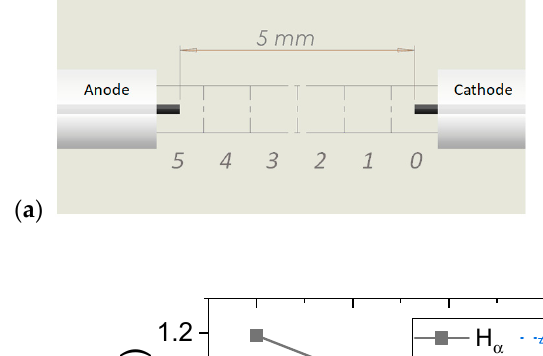
Figure 4. Optical emission spectra (U = 12 kV, σ = 100 µS/cm, gap = 5 mm, spatial resolution of 1 mm, exposure time = 200 µs, 100 accumulations per spectra).